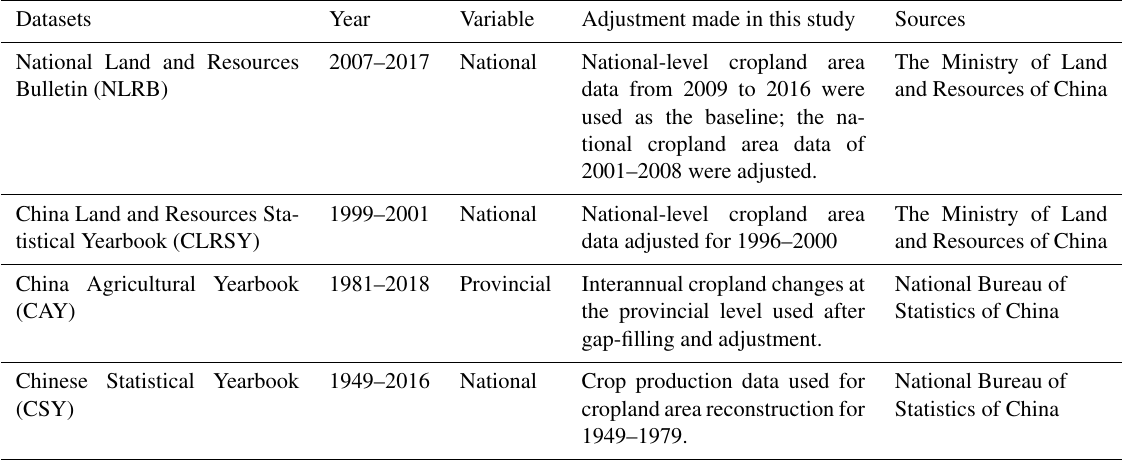
Table 1. Data sources of the cropland inventory.